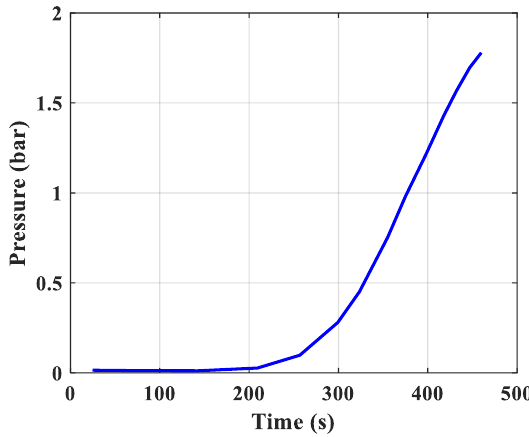
Figure 12. The result of partial pressure (O 2 ) following over time at 8 bar.